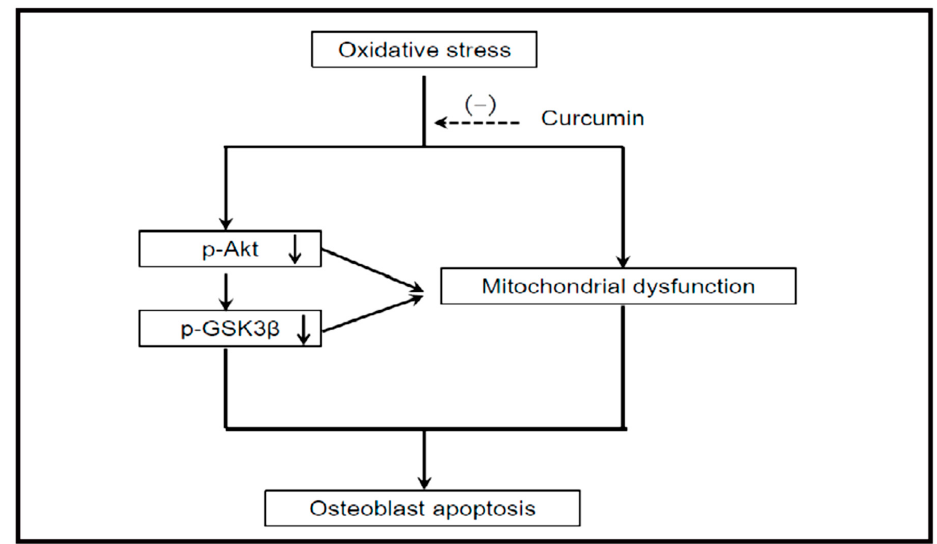
Figure 2. Working hypothesis: Curcumin administration ameliorated oxidative stress-induced apoptosis in osteoblasts through preserving mitochondrial function and activating Akt–GSK3 β signaling. Adapted from Dai et al. [54].